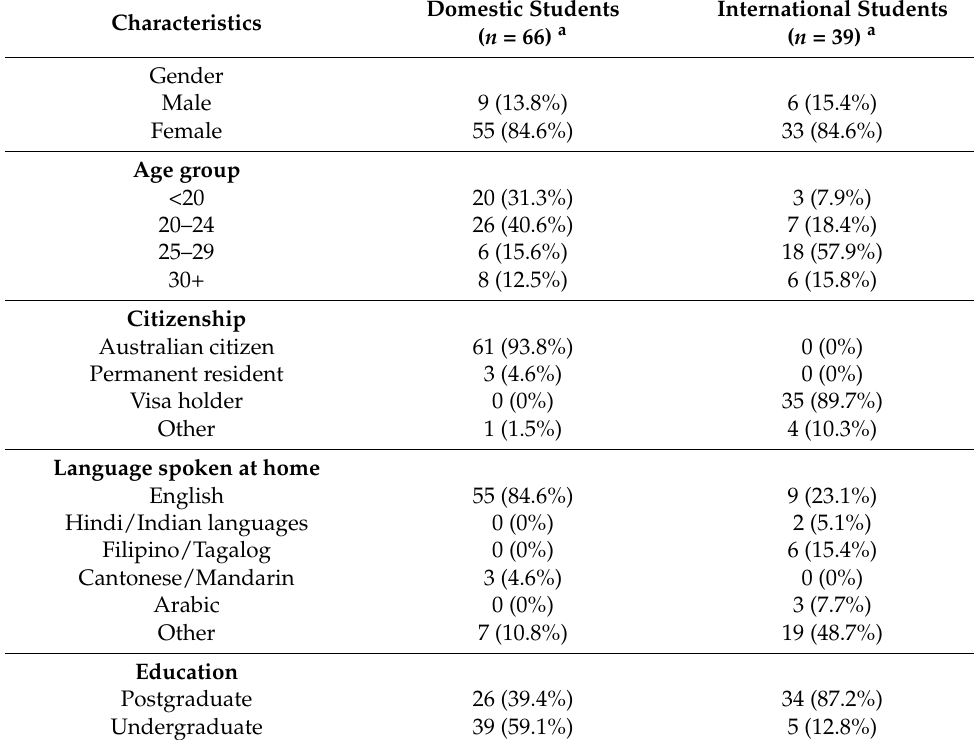
Table 1. Sociodemographic characteristics of the students (N =